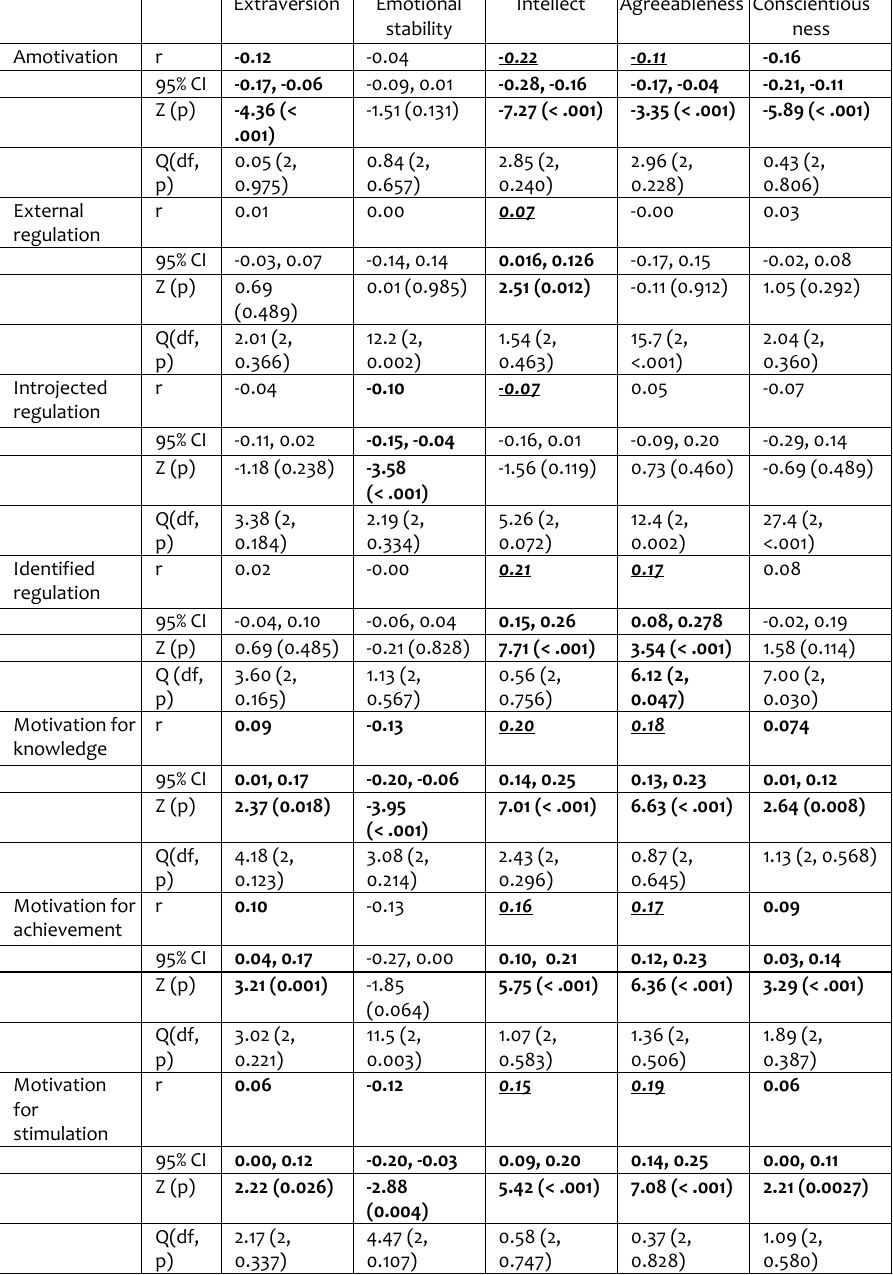
Table 1. Basic parameters of meta-analysis between L2 learning motivation and personality traits Extraversion Emotional Intellect Agreeableness Conscientious stability